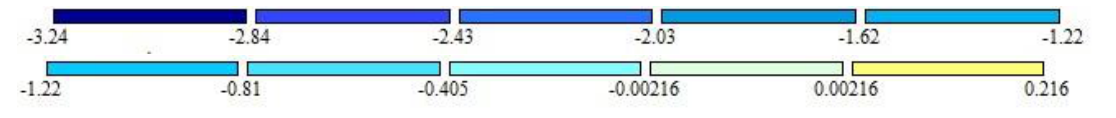
Figure 7. Isolation of normal voltages in t/m 2 .